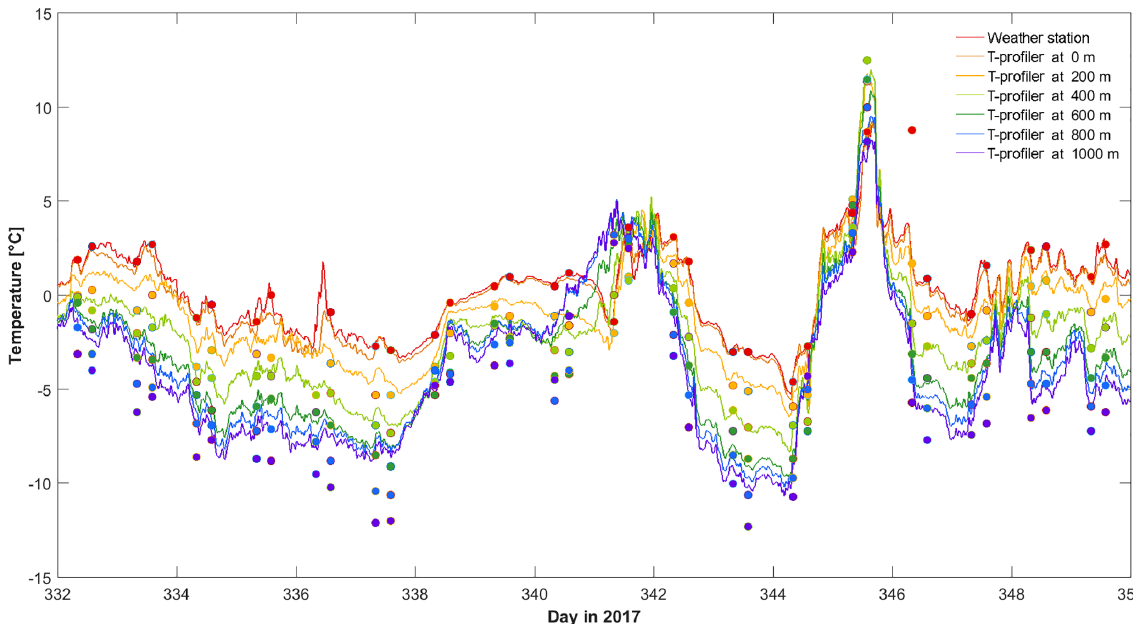
Figure 5. Temperature profiler (T-profiler) time series at particular heights compared to the temperature record of weather station and radiosonde data at equivalent heights (dots).